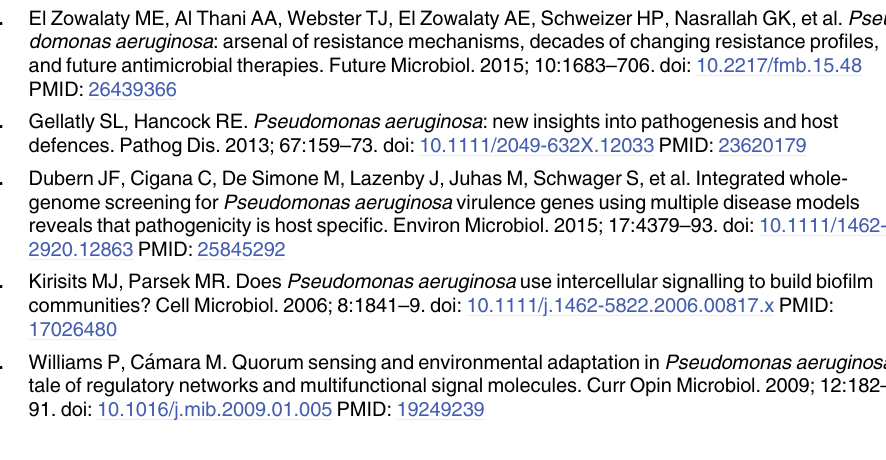
P pqsR :: lux ( C and D ). White bars indicate the pvdS -proficient genetic backgrounds ( Δ 4AQ and Δ 5AQ); grey bars indicate the pvdS -mutant genetic backgrounds ( Δ 4AQ Δ pvdS and Δ 5AQ Δ pvdS ). Strains were grown in LB or in LB supplemented with 40 μM HHQ or PQS, as indicated. Diamonds indicate the pyoverdine levels measured in culture supernatants in the pvdS -proficient (white diamonds) or pvdS -mutant (grey diamonds) genetic backgrounds. Pro- moter activity is reported as Relative Light Units (RLU)/OD ; pyoverdine levels are reported 600 as OD normalized to cell density (OD ). ( E ) Maximal P pqsA :: lux and P pqsR :: lux promoter 405 600 activity in the wild type (white bars) and Δ pvdS (grey bars) strains grown in LB. Promoter activity is reported as Relative Light Units (RLU)/OD . ( F ) E . coli H1717 cells containing the 600 plasmids indicated and grown for 24 h at 37°C on McConkey agar supplemented with 10 μg ml -1 Tc and 20 μM FeSO . Red-staining indicates the ability to ferment lactose and hence the 4 binding of Fur to the target promoter. miniCTX-P pchR :: lux ,positive control (red colonies); miniCTX- lux ,negative control (white